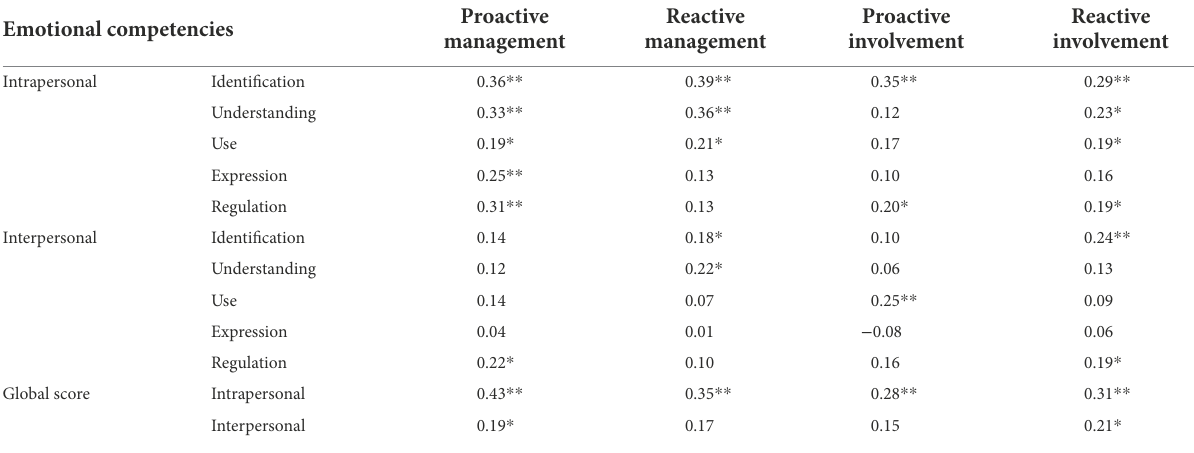
TABLE 1 Results of Pearson’s correlations between the 12 scores of emotional competencies and the four dimensions of perceived self-efficacy in classroom management. Emotional